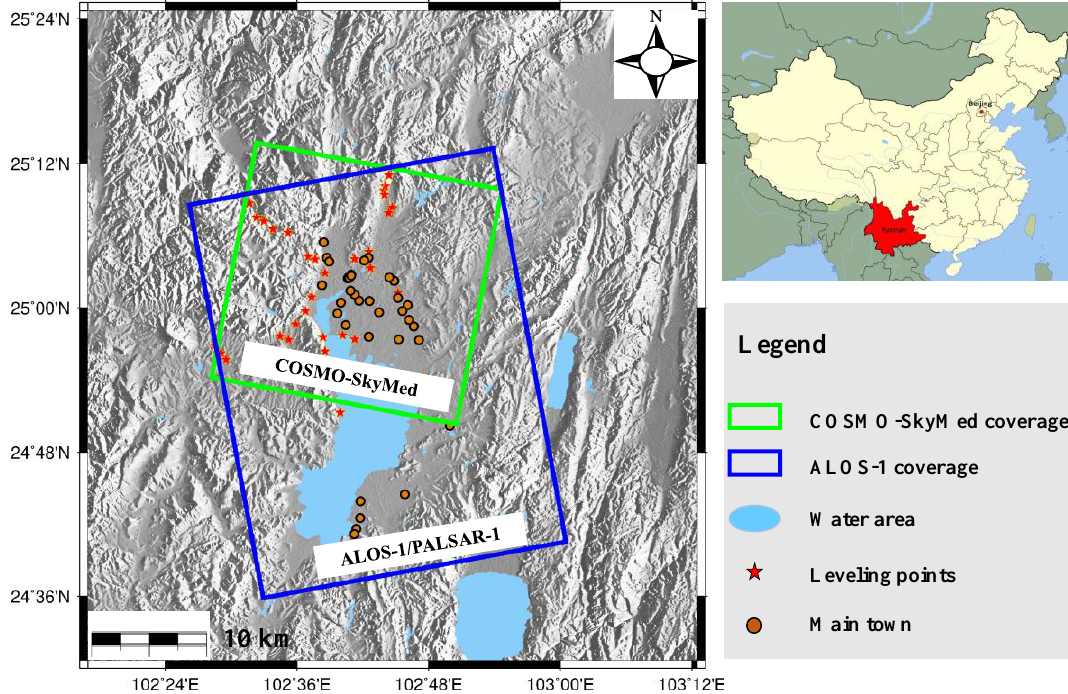
Figure 2. Study area and synthetic aperture radar (SAR) data coverage used in this study; corresponding data are superimposed on the digital elevation model (DEM).